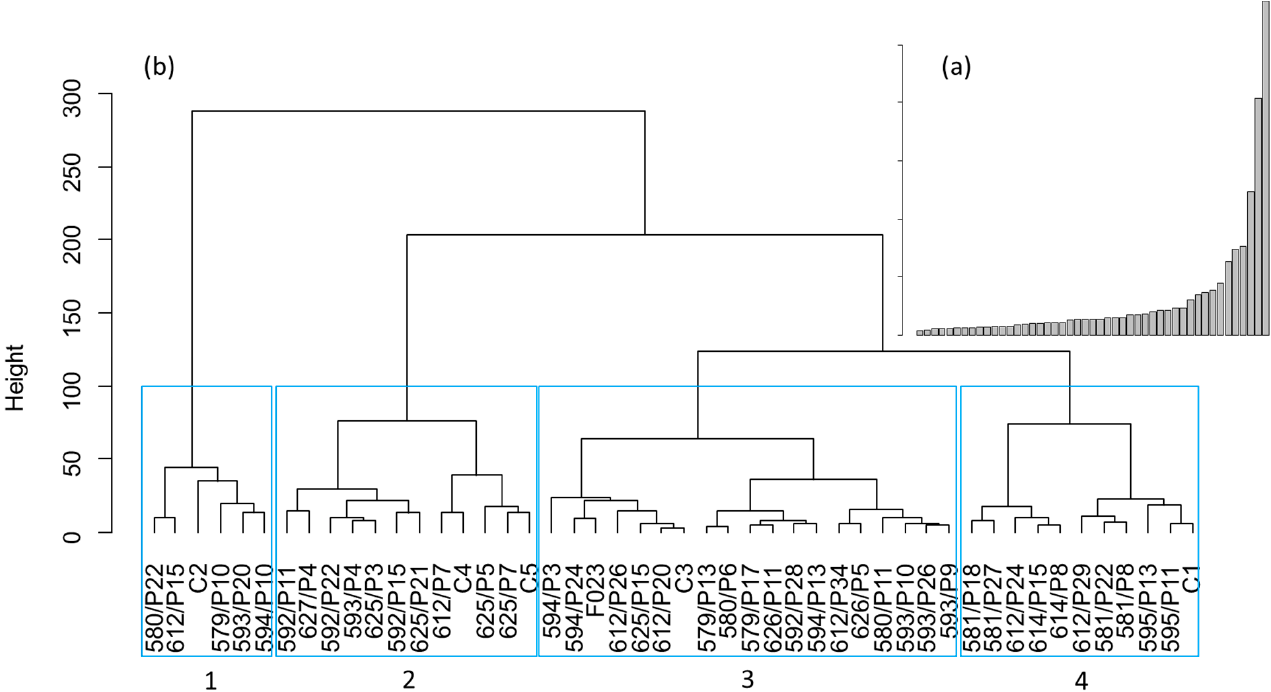
Figure 2. Hierarchical clustering of the 48 kilns according to eight topographical and morphological variables; ( a ) bar plot of aggregation height; ( b ) dendrogram of kilns computed with Ward’s method. The blue rectangle contains the four clusters identified.